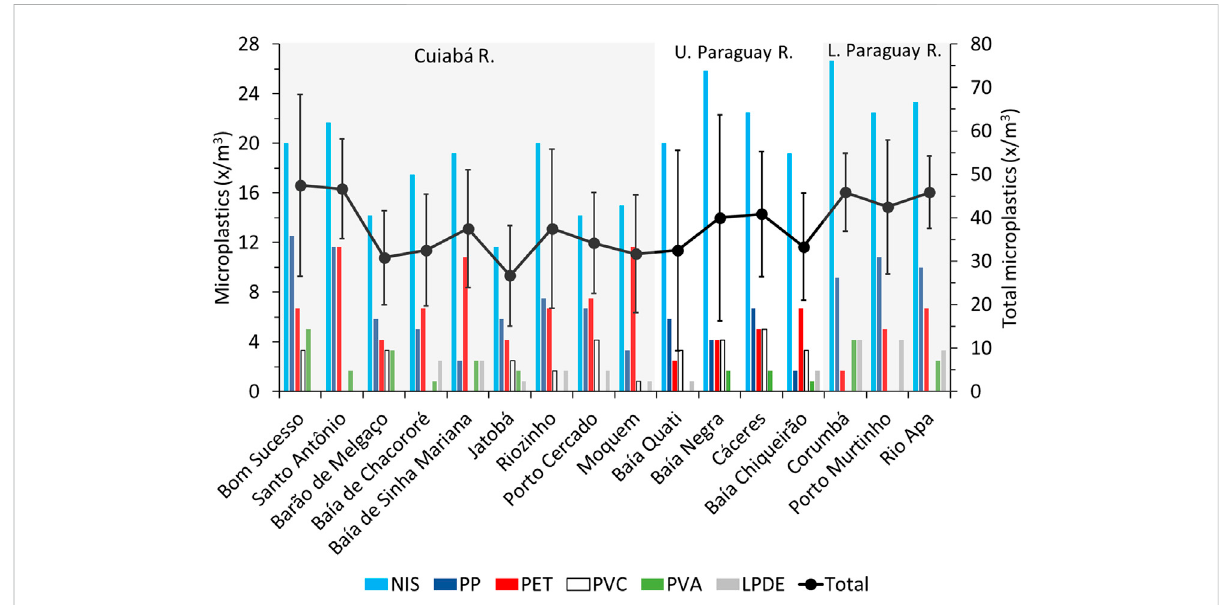
FIGURE 3 Average microplastic composition at sampling sites. Total microplastic concentration on the right vertical axis. Microplastics concentration for each specie on the left vertical axis. Cuiabá R. = Cuiabá River Zone; U. Paraguay R. = Upper Paraguay Zone; L. Paraguay R. = Lower Paraguay Zone. See Figure 1 for localization. NIS: non-identi fi ed synthetic; PP: polypropylene; PET: polyester; PVC: polyvinyl chloride; PVA: polyvinyl alcohol; LDPE: low-density polyethylene. The vertical bar associated with each average total microplastic composition is ± the standard deviation.